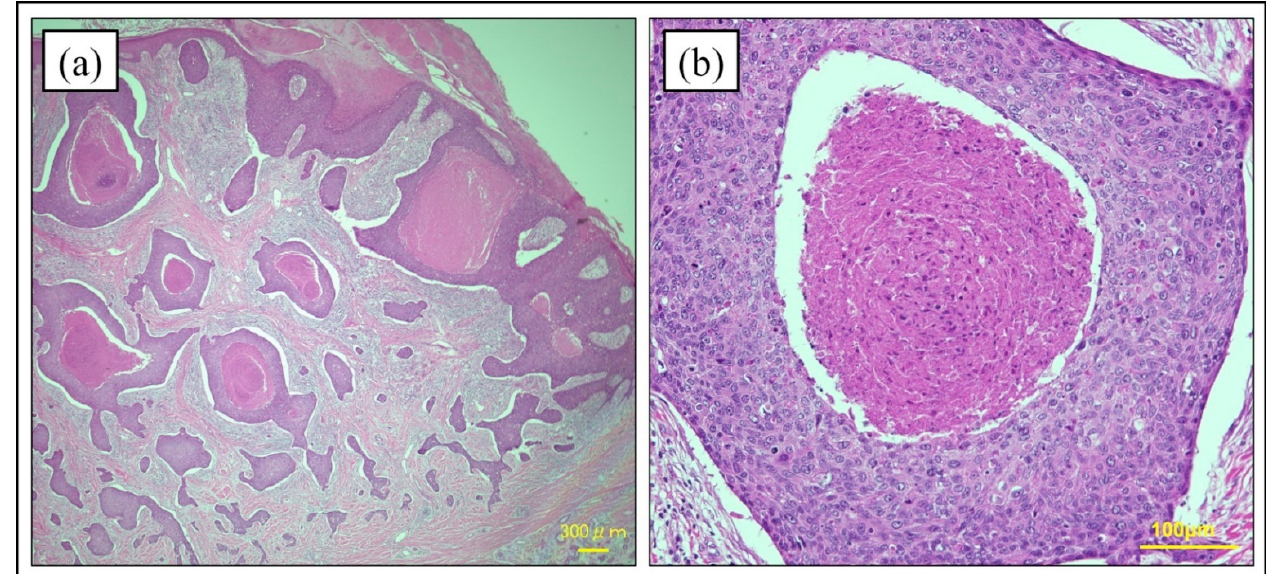
Figure 2. Histopathological findings of comedo necrosis. ( a , b ) Clusters form irregular nests of various sizes in the intraepidermal. The large nests are accompanied by many comedo necroses. (Hematoxylin and eosin stain; ( a ) original magnification ×20, ( b ) original magnification ×200).